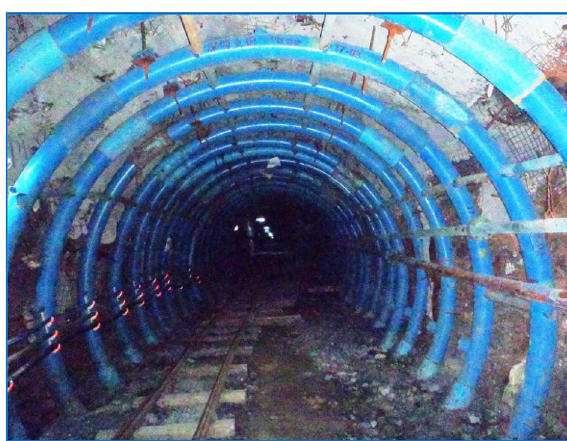
Figure 9. Field application of the CSTS supporting technology.